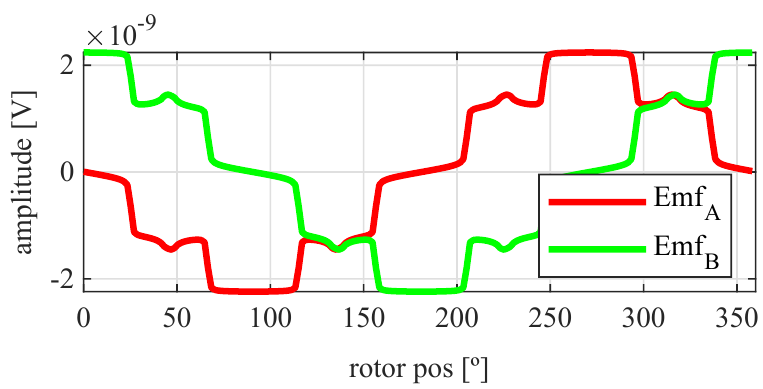
Figure 5. Full pitch four-slot resolver EMFs with the least THD. After applying the skew, the results shown in Figure 6 were obtained. In Figure 6a, the original EMFs to which the skew was applied, and, in Figure 6b, the EMFs with skew are shown. Comparing Figure 6a to Figure 5, it can be deduced that the ks and kr parameters for the resolver with and without skew are different, thus, it is important that, for each topology the skew must be analysed for every parameter combination.